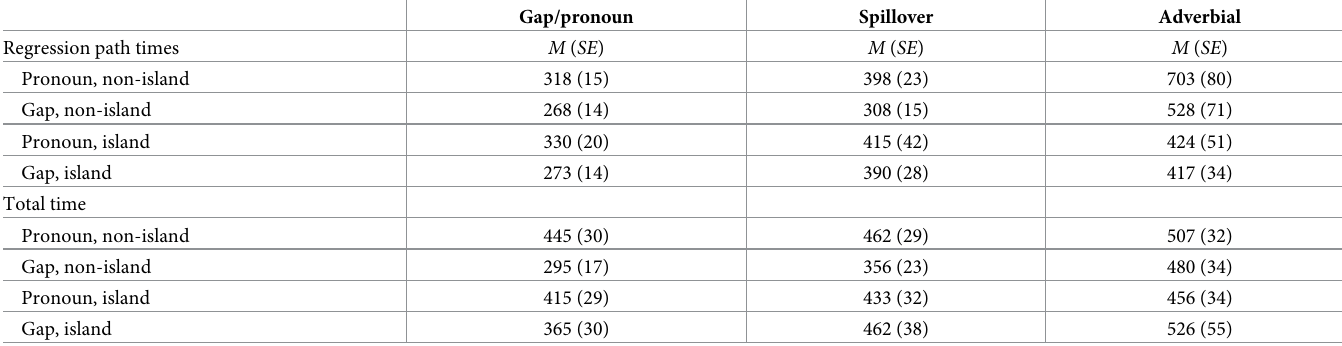
Table 2. Means (and standard errors), in milliseconds, for regression-path times and total time for Experiment 1. Gap/pronoun Spillover Adverbial Regression path